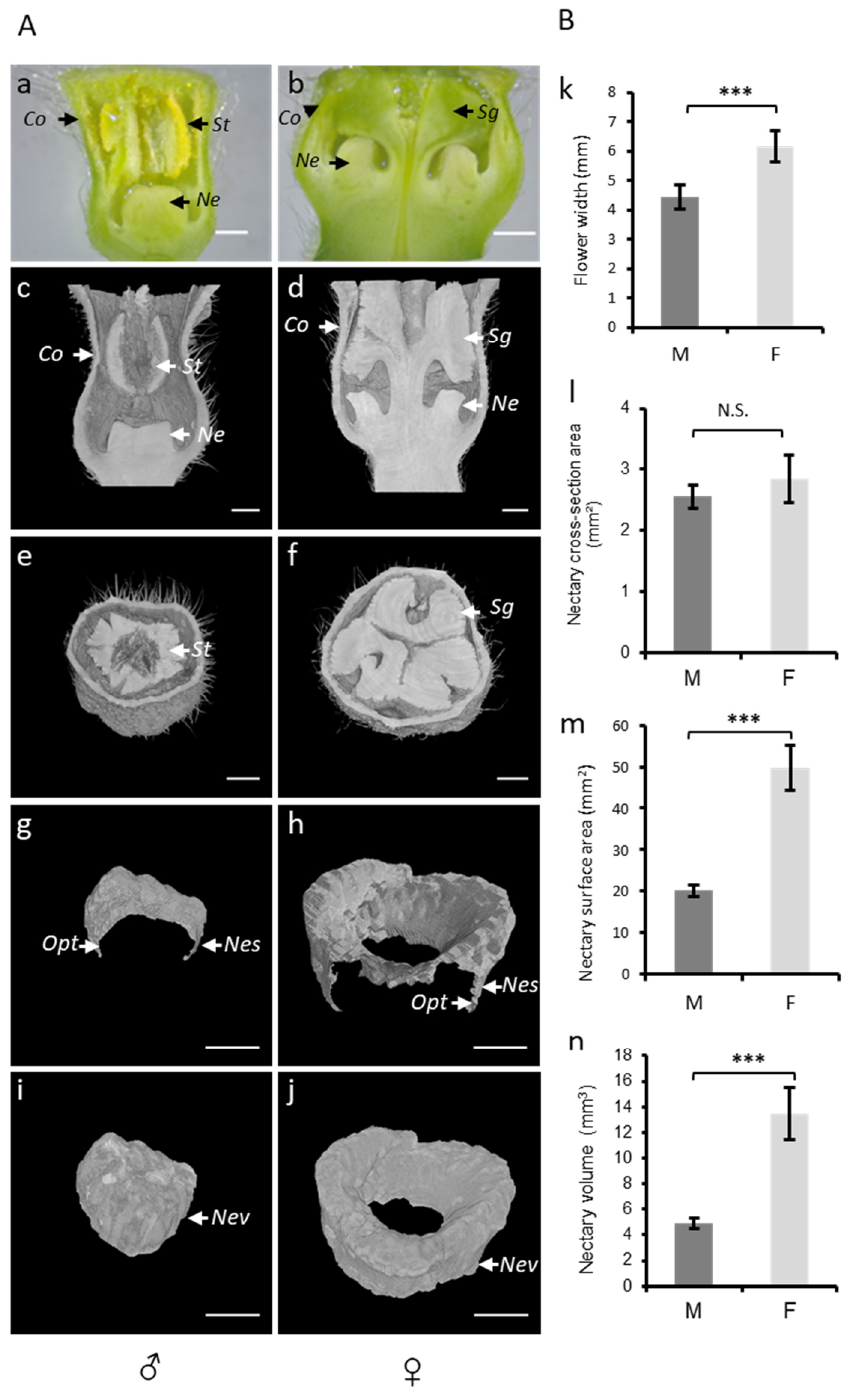
Figure 4. ( A ) Analysis of melon flowers at anthesis stage using a stereomicroscope and microtomog‑ raphy. Transversal view of ♂ ( a ) and ♀ ( b ) flowers under a stereomicroscope. Microtomographic transversal and sagittal views of ♂ ( c , e ) and ♀ ( d , f ) flowers. Three‑dimensional cross sectional views of total 2D nectary surface area ( g , h ) and 3D views of total nectary volumes ( i , j ) extracted from 3D models of flowers types ( ♂ , ♀ ). St, stamen; Sg, stigma; Co, corolla; Opt, one pixel thickness; Ne, nectary; Nes, nectary surface; and Nev, nectary volume. The scale bar represents 1 mm. ( B ) compar‑ ison of 2D and 3D parameters between flower types ( ♂ , ♀ ): flower width ( k ), cross‑sectional nectary area ( l ), total 2D nectary surface area ( m ), and nectary volume ( n ) of ♂ and ♀ flowers calculated using microtomography. Male = M; female = F; N.S. = not significant; *** = p < 0.001.